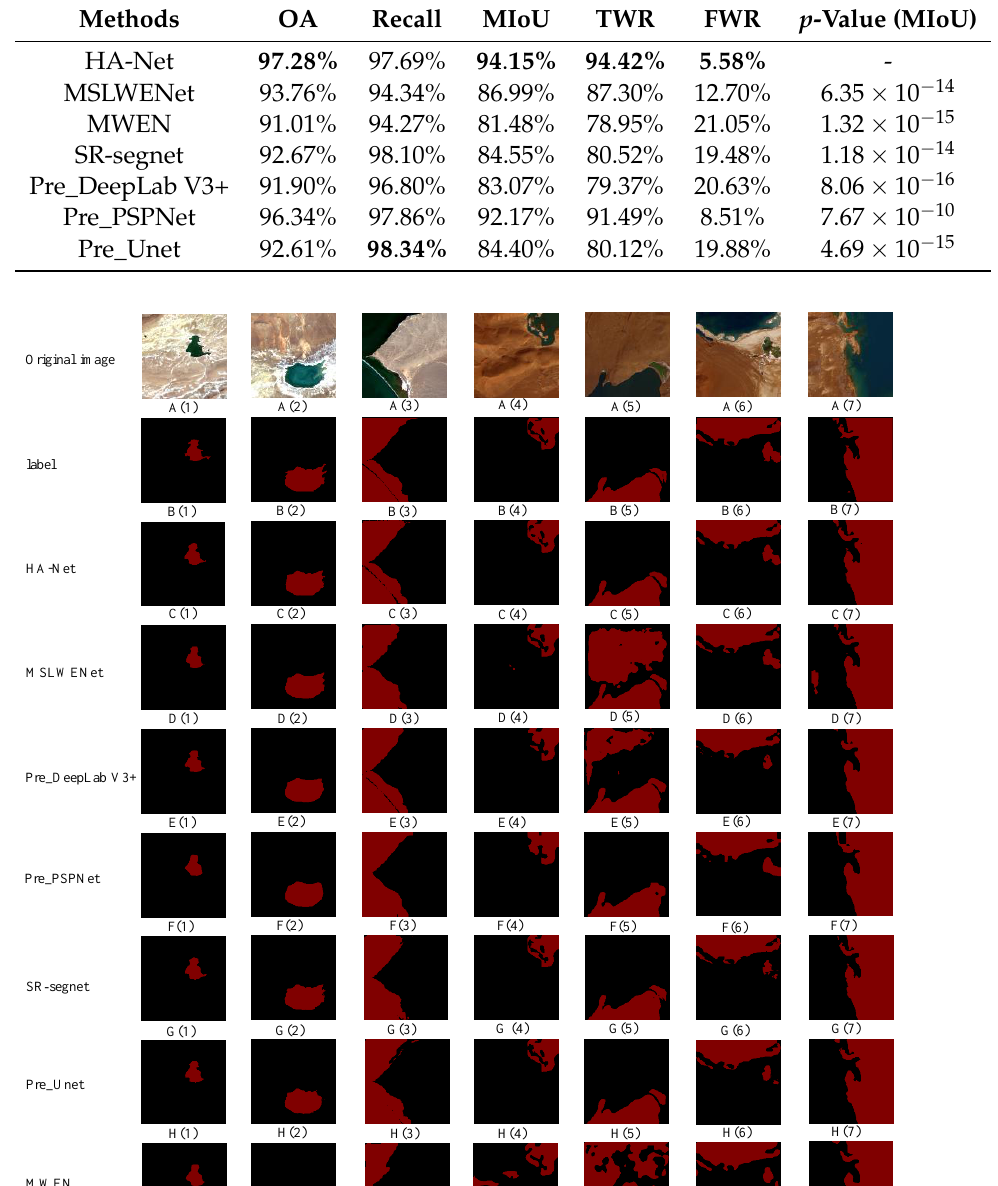
Table 7. The quantitative results of comparing the proposed method against other methods on the Landsat-8 dataset.